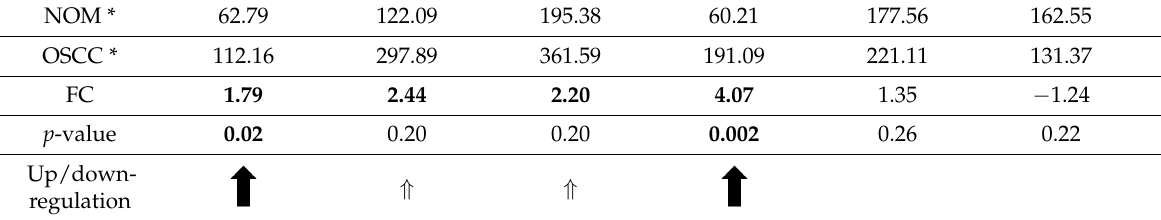
Figure 2. Boxplots of the comparison of expression rates of immune modulators between OSCC and NOM groups. Only results for genes that are significantly deregulated are shown. Analysis of ( A ) specific cell markers for MDSCs (CD115) and macrophages (CD68, CD163), ( B ) activating ligands (CD86, CD28, CD137L), ( C ) inhibitory receptors and ligands (CD96, PD-L1, GIRTL), ( D ) not signif- icantly but highly dysregulated modulators (CD8, BTLA, PD-1). Number of cases of OSCC n = 98 and NOM cases n = 41. * = extrem value. Table 3. Statistical analysis of differential expression of immune modulators in OSCC ( n = 98) compared to NOM group ( n = 41). Mean values of expression, expression differences (FC) and statistical significance expressed as p -values (MWU test) are reported. * Average of counts in the group. Statistically relevant changes are highlighted in bold. The genes are over-/under-expressed about two fold, but the change of differential eypresion do not reach statistic relavance between the compared groups.